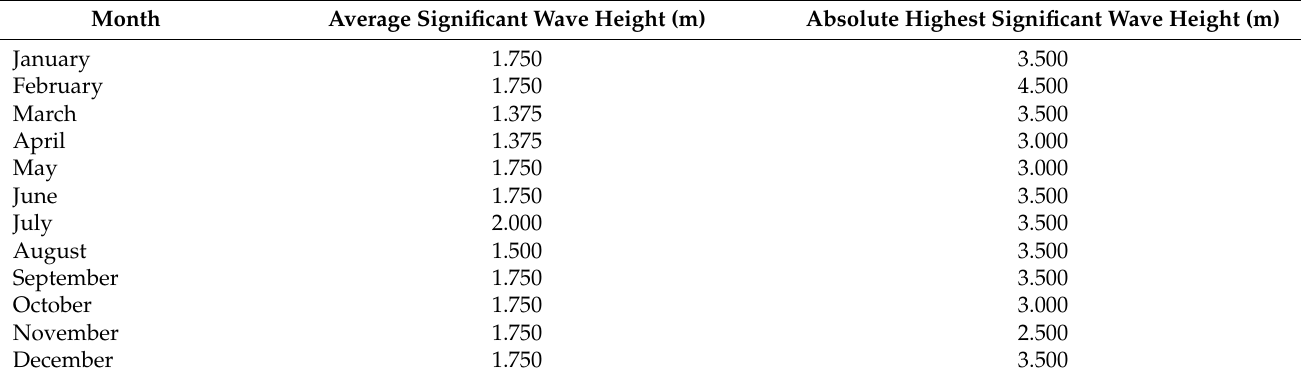
Table 3. Monthly significant wave height data during 2000–2010.